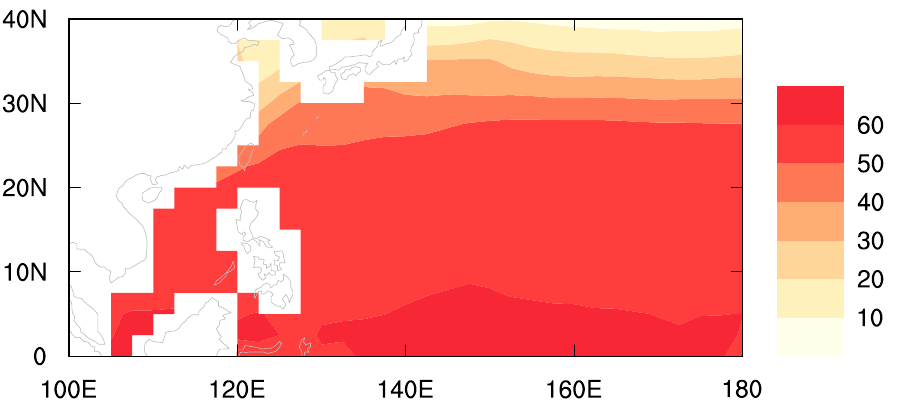
Figure 2. Climatological mean of TC potential intensity (PI) in the ERA-interim data. The unit is m s − 1